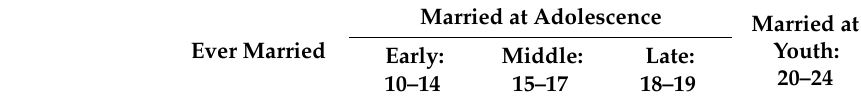
Table 1. Descriptive statistics by age at